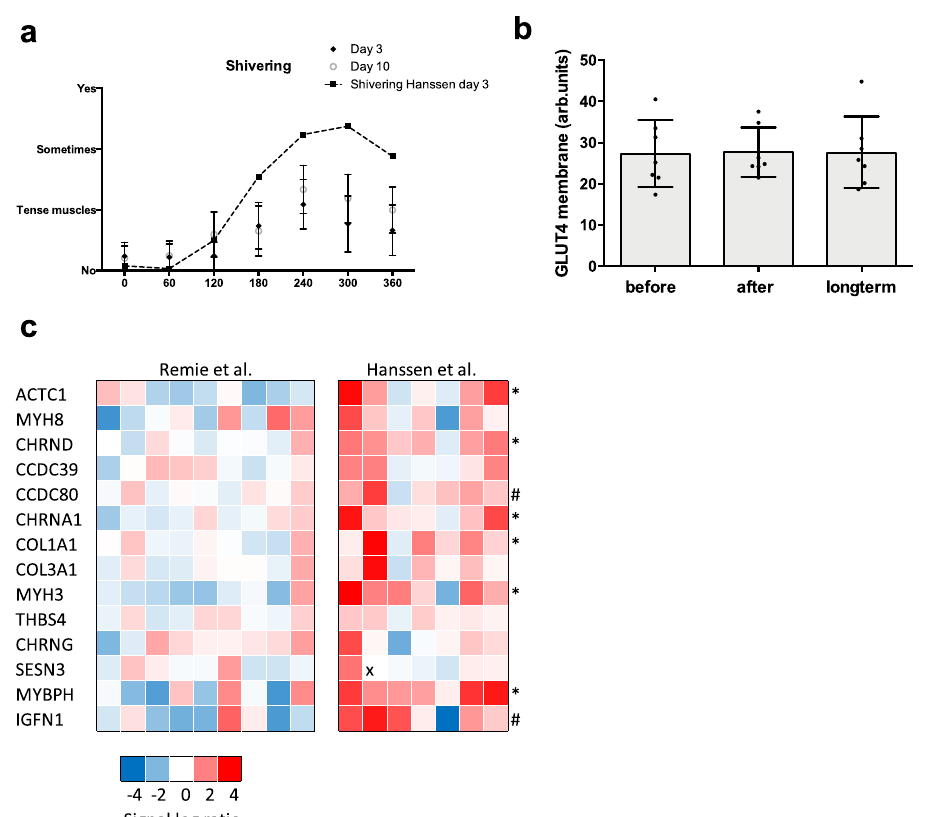
Fig. 6 Skeletal muscle activity markers. a Self-reported shivering measured with VAS scales at selected timepoints (from T = 0 min until T = 360 min) during day 3 ( n = 9) and day 10 ( n = 9) of the mild cold acclimation period, shown as AUC. The dashed line indicates the self-reported shivering AUC from Hanssen et al. 13 at day 3 ( n = 8). b GLUT4 intensity at the skeletal muscle membrane, expressed as arbitrary units (arb.units) ( n = 7). c Relative gene expression analysis in skeletal muscle biopsy samples obtained from the current study (Remie et al.) ( n = 9) and from Hanssen et al. 13 ( n = 7) before and after mild cold acclimation. qPCR data is expressed as heatmap. Ampli fi cation failed for one sample and has been identi fi ed by “ x ” in the heat map. Data was analyzed with a two-sided Wilcoxon matched-pairs signed rank test for shivering. Data was analyzed with a two-sided Friedman test for GLUT4. Data was analyzed with a two-sided Mann – Whitney test for relative gene expression. Data are shown as mean ± SE. * p < 0.05, # p <